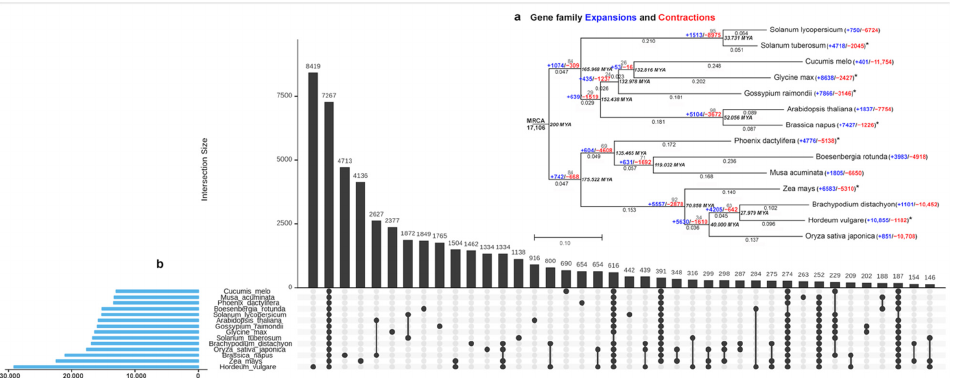
Figure 4. ( a ) cross-genera phylogenetic analysis of B. rotunda and 13 other species. Aterisks after the expansion and contraction figures indicate genomes with reported ancient whole genome duplication or massive segmental duplications or major chromosomal duplications; ( b ) UpSet plot showing unique and shared protein ortholog clusters of B. rotunda and 13 selected reference genomes. Connected dots represent the intersections of overlapping orthologs with the vertical black bars above showing the number of orthogroups in each intersection.